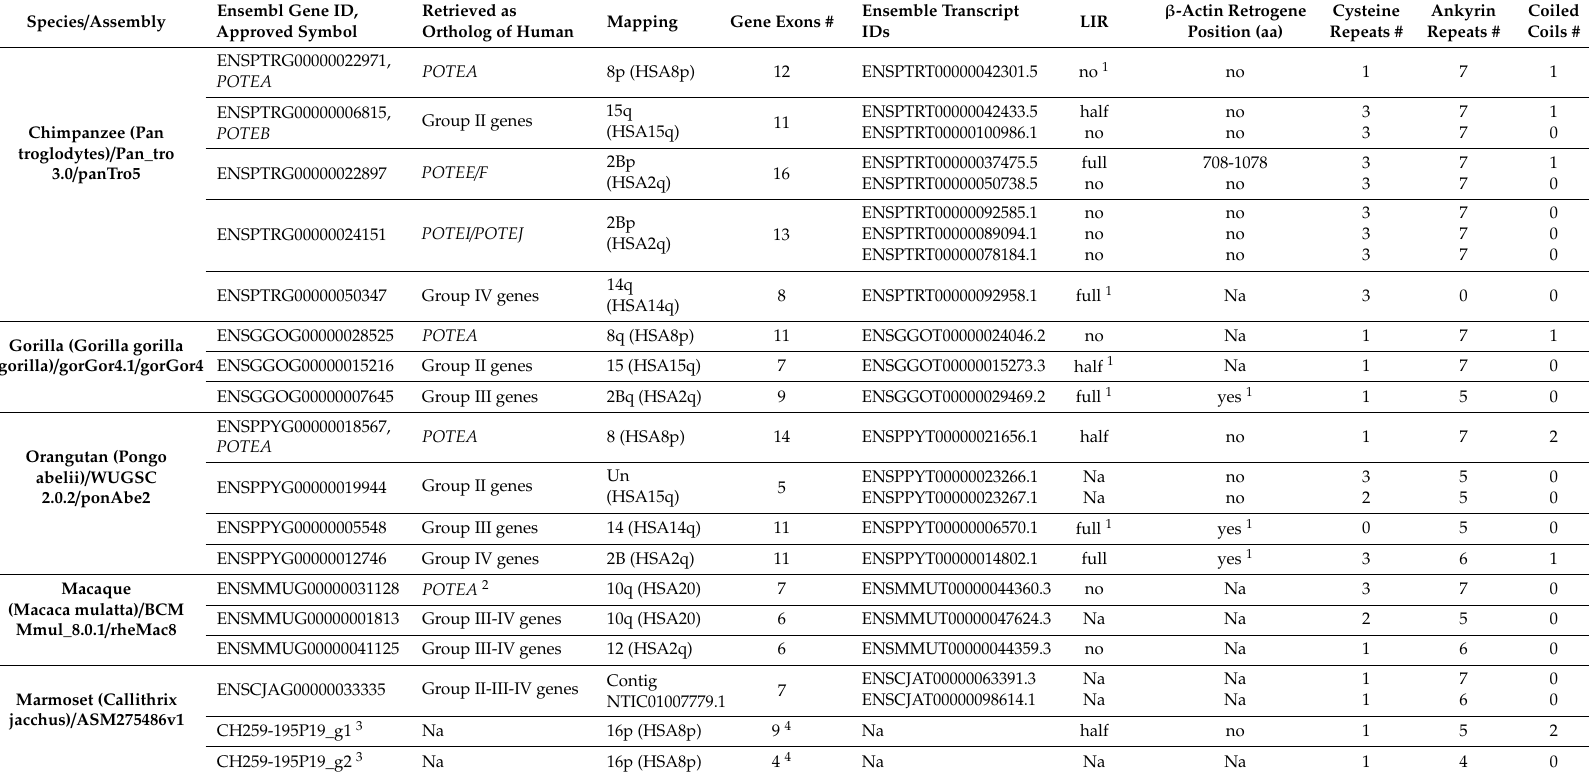
Table 3. Primate POTE genes and corresponding transcript features and